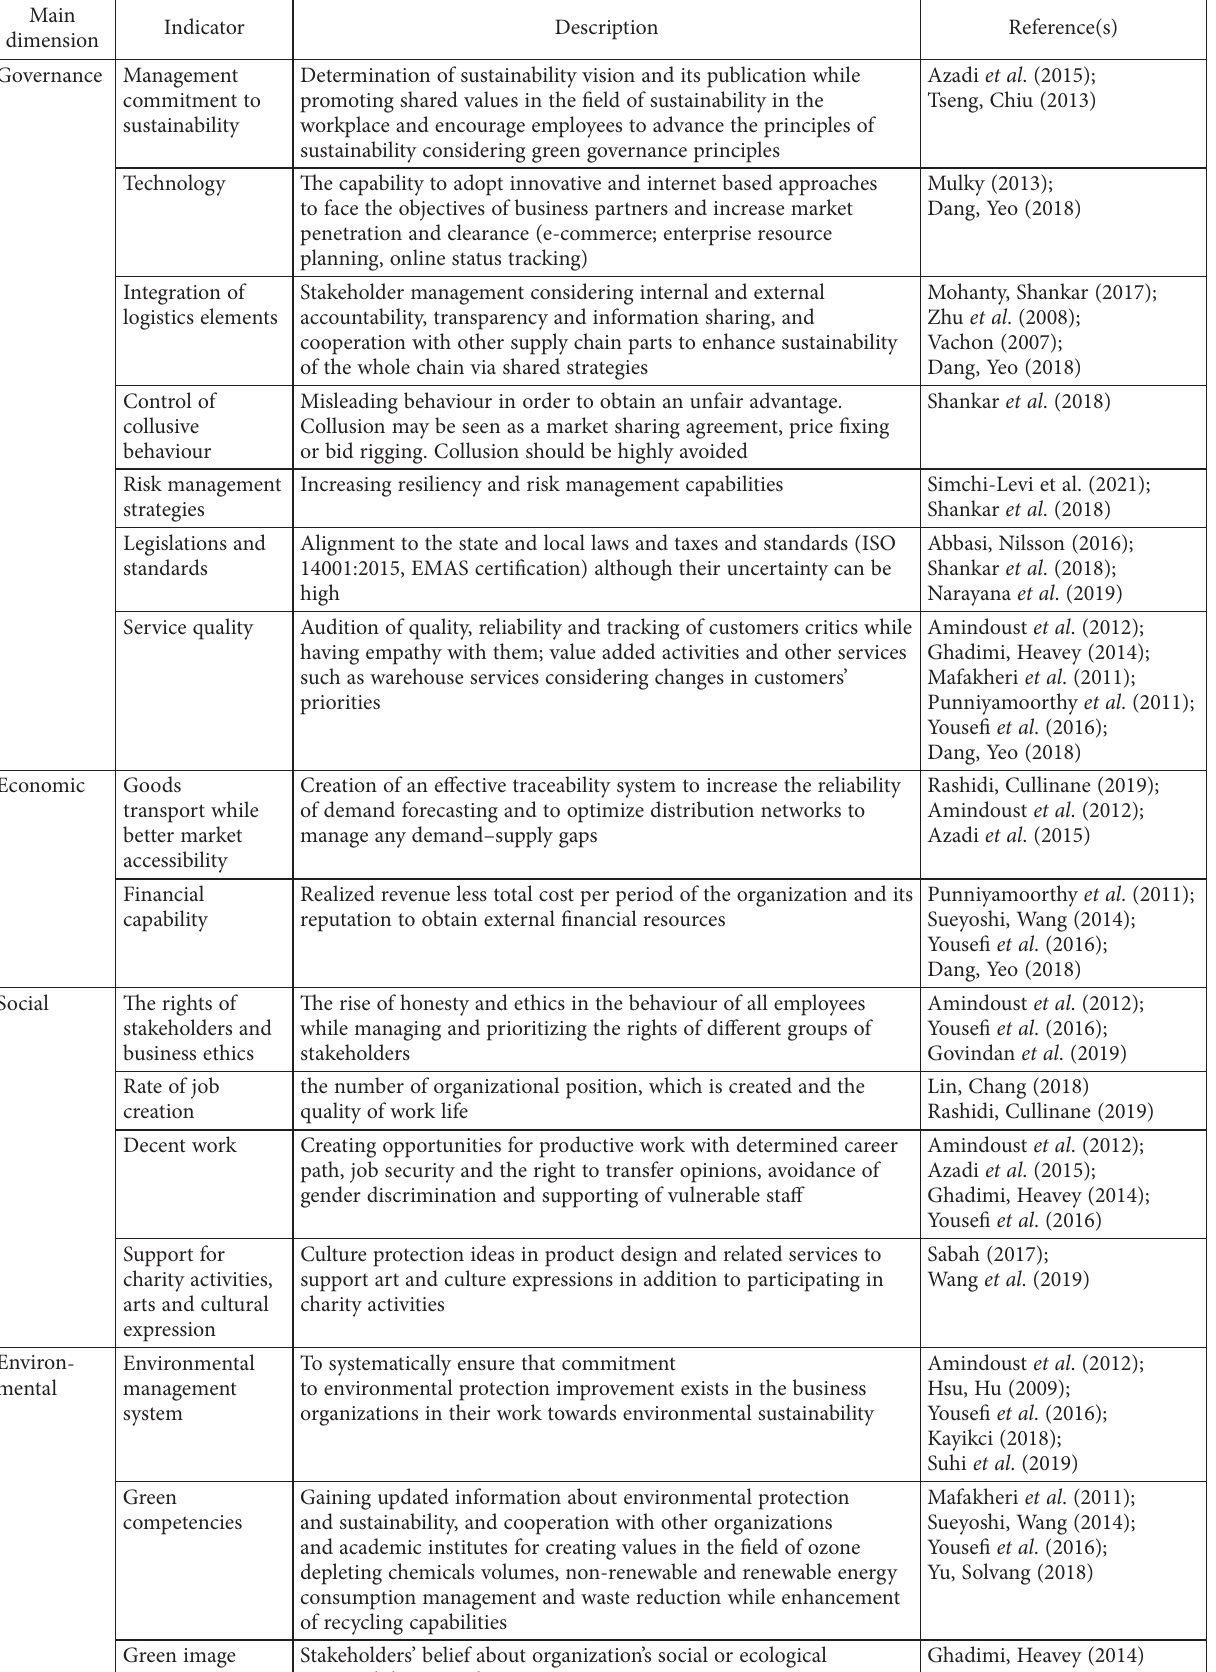
Table 1. Components for making FMCG supply chain